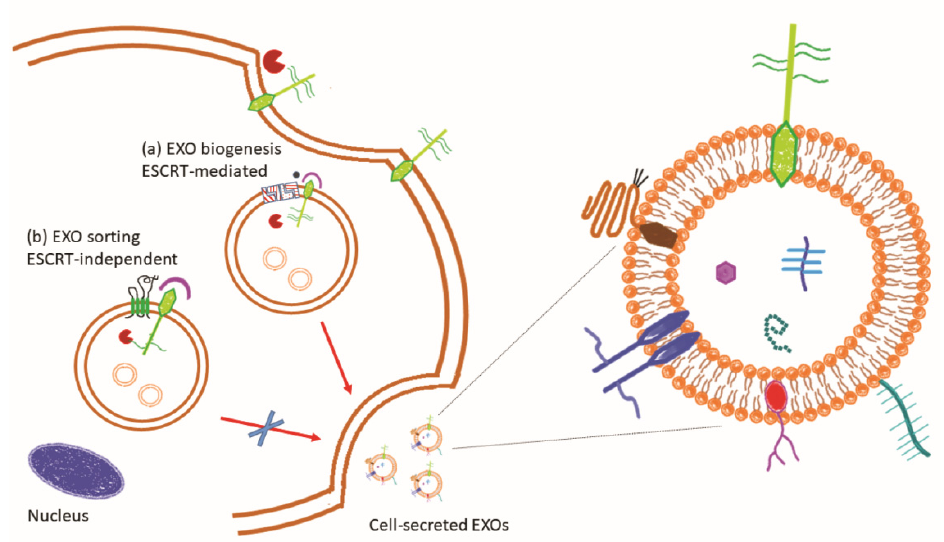
Figure 1. Graphical sketch of glycans involved in EXO biogenesis and release. Representative process of ( a ) EXO biogenesis and secretion (endosomal sorting complex required for transport (ESCRT)-mediated) with the participation of the cell surface syndecan-1, in the syndecan-1-syntetin-ALIX complex [54,55,65–71]; ( b ) syndecan-4–syntenin interaction in the balanced exosomal secretion under tetraspanin-6 negative control [57,72,73]. Mammalian cell EXO-magnification of the main investigated glycans (see Figure A1 in Appendix A for symbol interpretation).